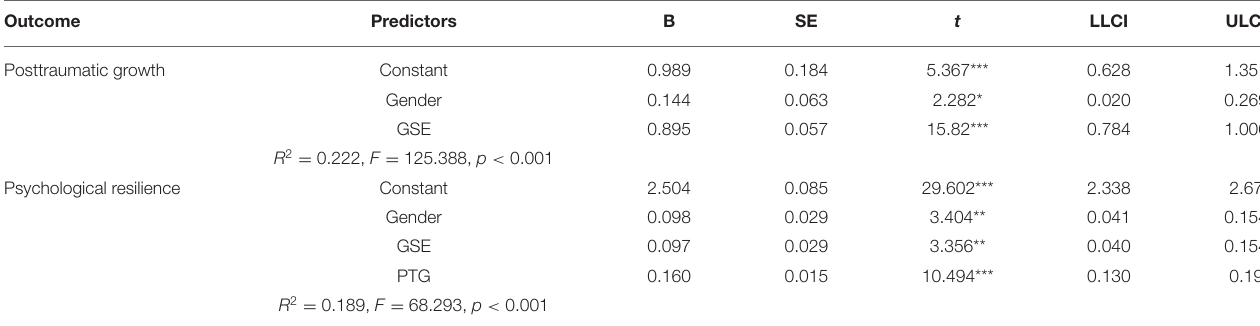
TABLE 2 | Regression results for mediation analysis ( N =